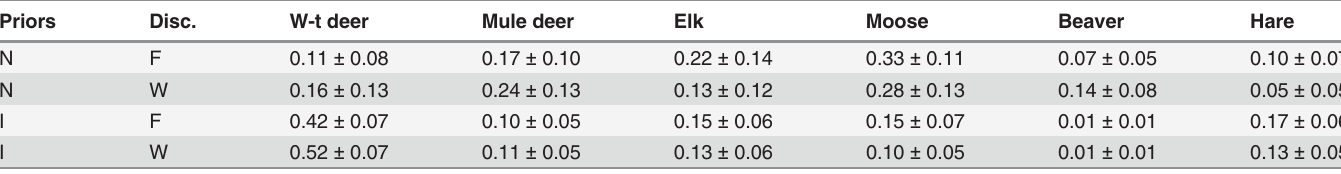
Four models were speci fi ed with two different prior distributions (i.e., non-informative [N], and informative [I]) and two different discrimination factors (i.e., red fox [F] and wolf [W]).